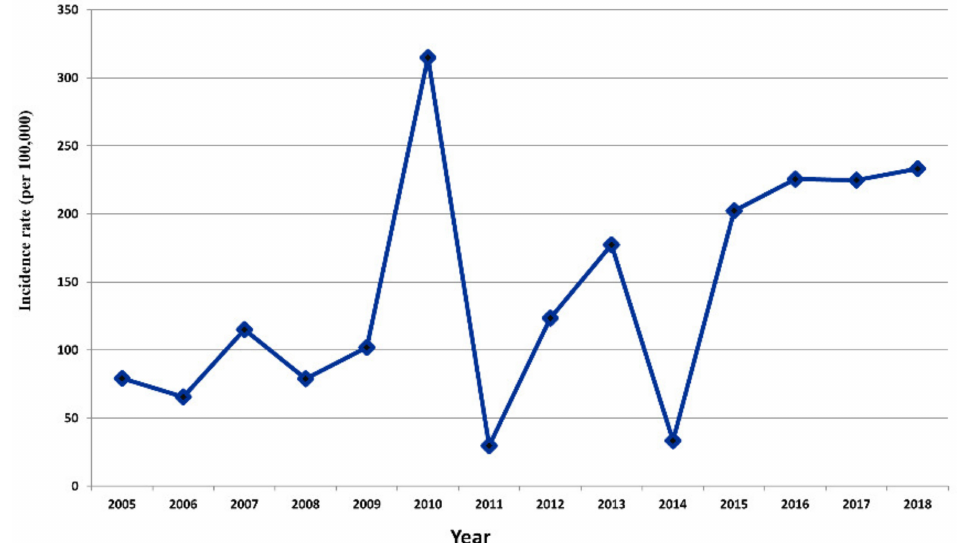
Figure A1. Annual dengue incidence (per 100,000) in central Vietnam between 2005 and